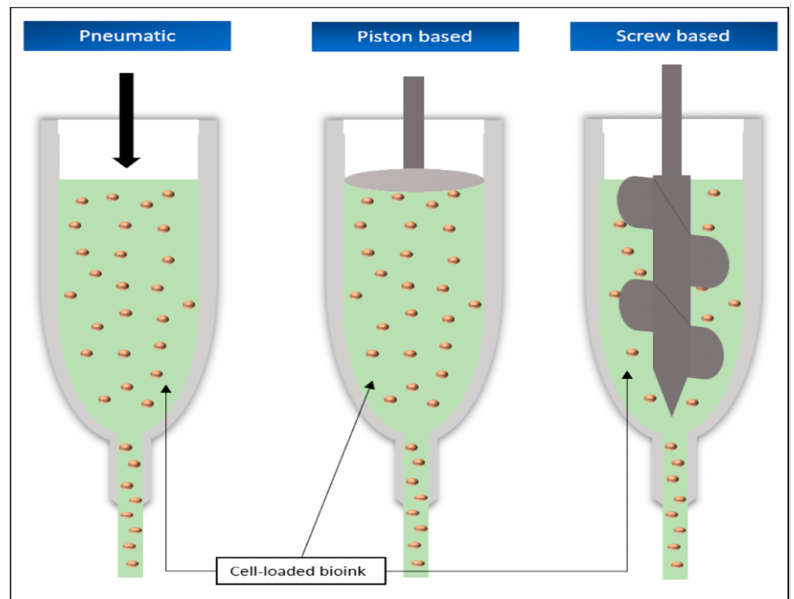
Figure 4. Schematic representation of the extrusion-based printing technologies. All applications have in common the use of a force directed at the nozzle to eject the